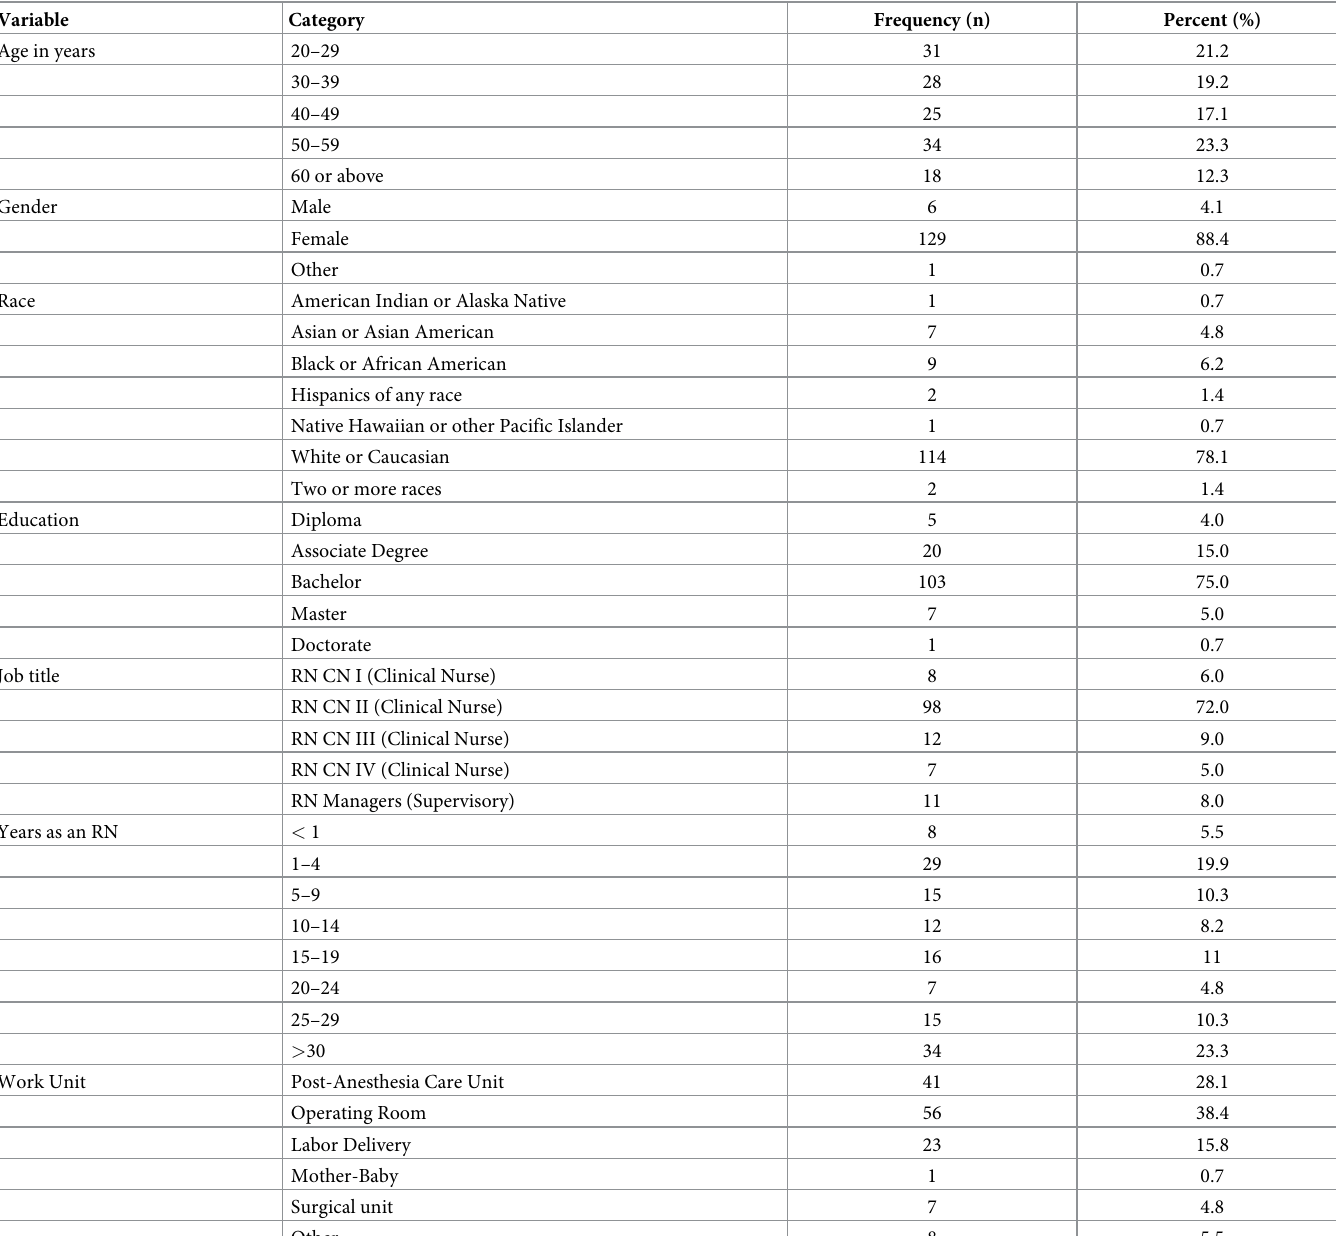
Table 1. Frequency distributions and percentages of categorical demographic variables (n =